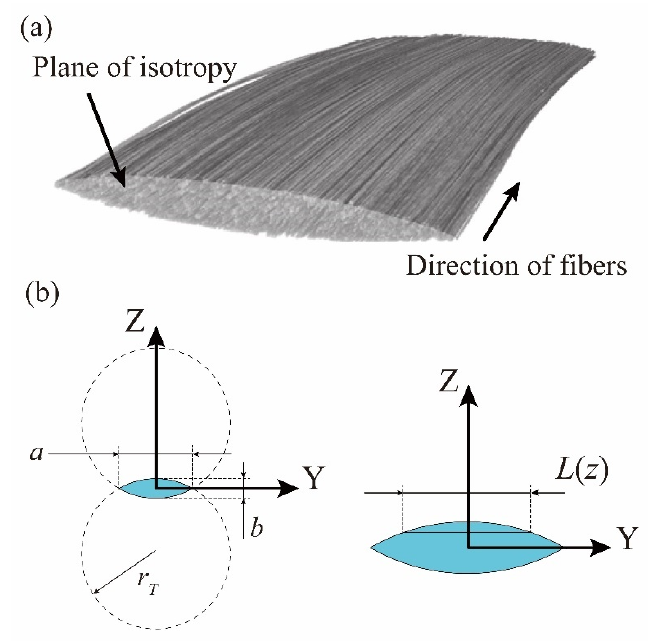
Figure 1. The lenticular-shaped cross-section of the fiber tows and the corresponding geometric parameters: ( a ) experimental CT image of the fiber tow [29]; ( b ) geometric parameters of the lenticular-shaped cross-section.